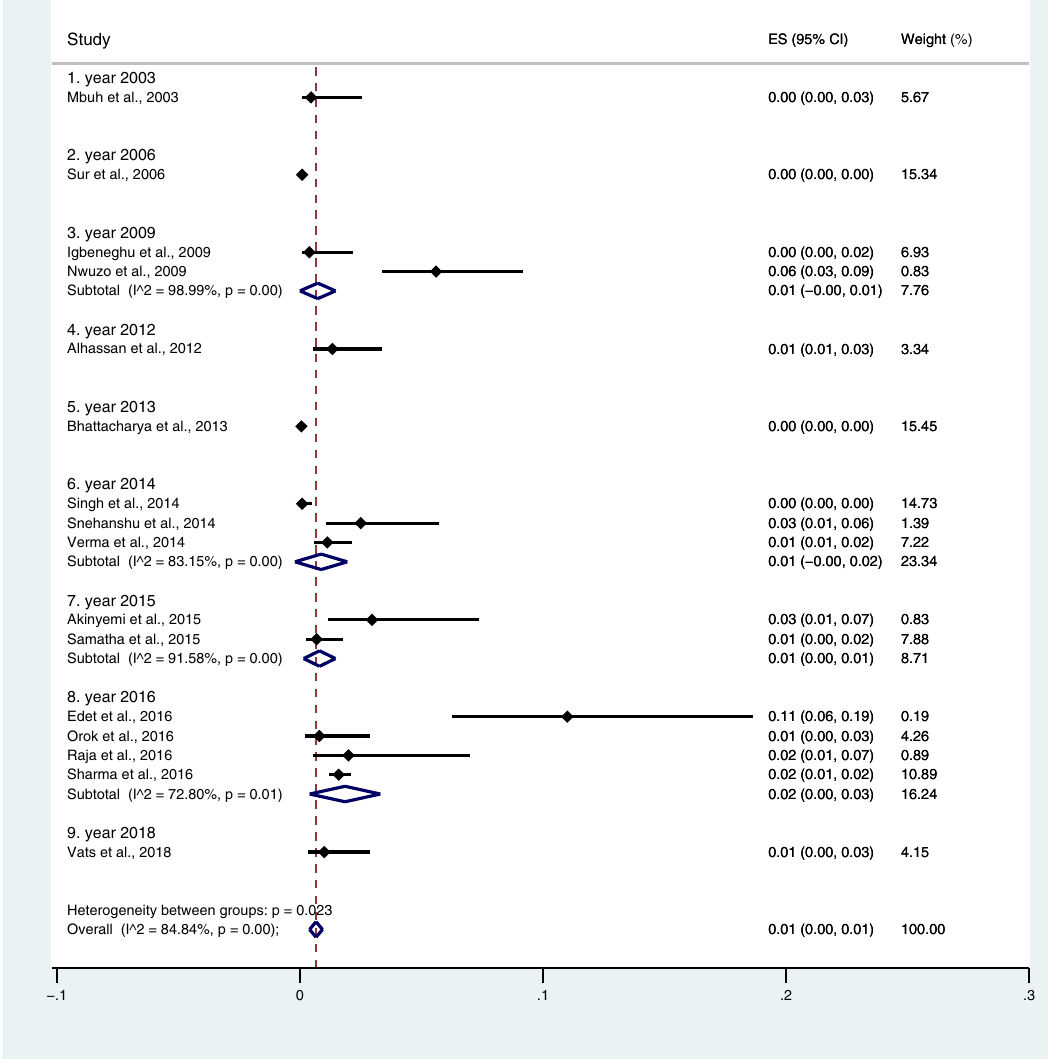
Figure 9. Pooled prevalence of typhoidal and malaria co-infection using blood cultures for the identification of Salmonella spp. infection stratified by time (publication year). ES proportion estimate (multiply 100 units for interpreted as prevalence estimate), CI confidence interval, NS not